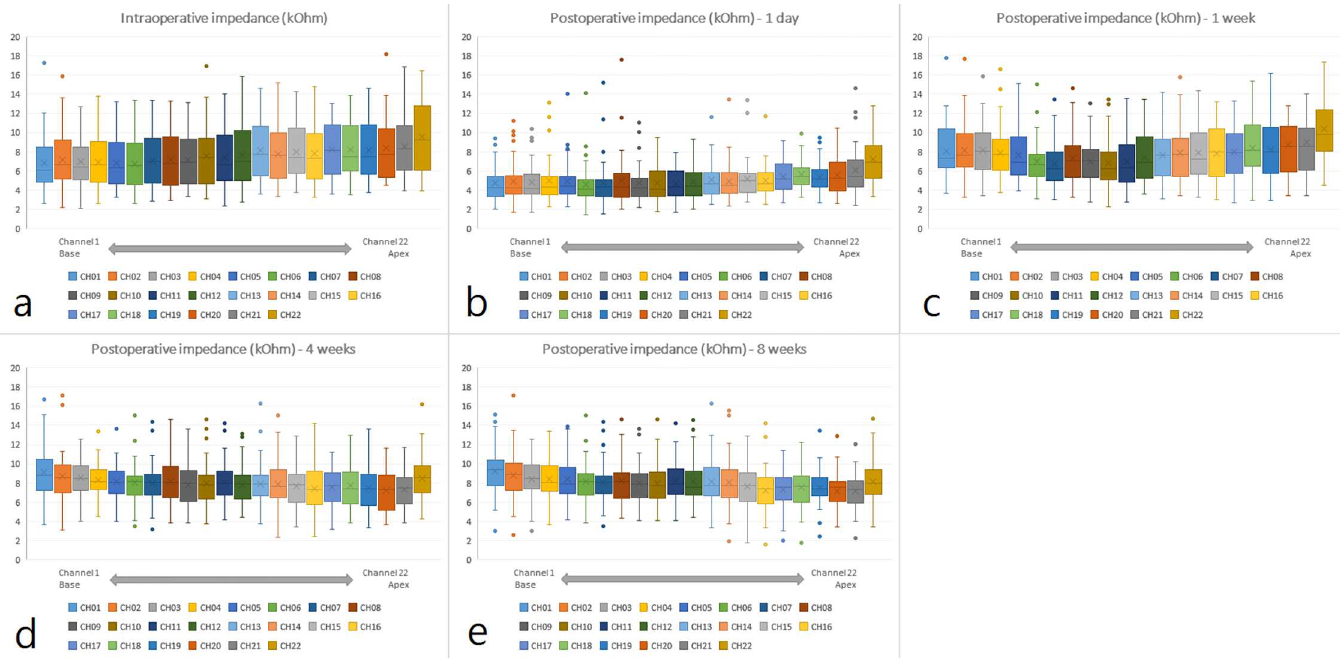
Fig 1. Impedance measurements for each of the 22 electrodes. Median values are displayedas horizontal lines and mean values as crosses. Circles denote extreme values. (a) Intraoperativemeasurements, (b) 1 day after surgery, (c) 1 week after surgery, (d) 4 weeks after surgery, (e) 8 weeks after